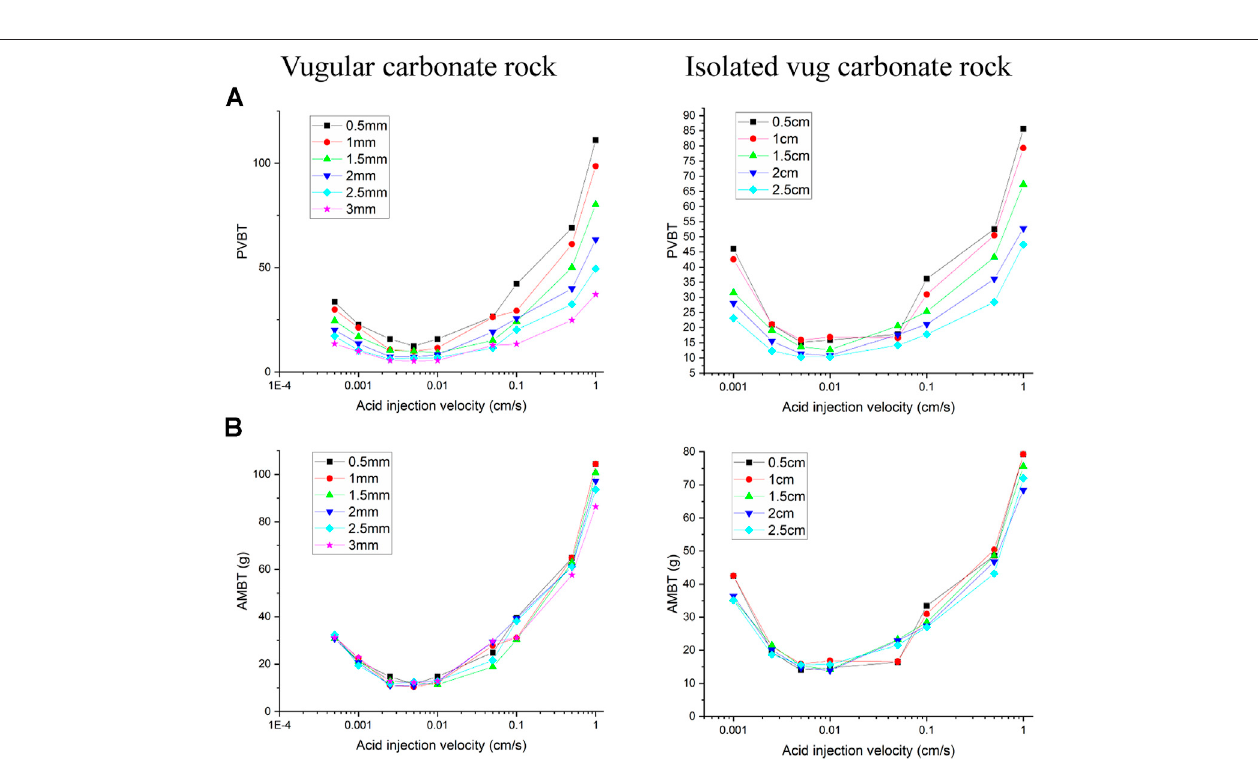
FIGURE 11 | Effect of vug diameter on acidizing curves: (A) pore volume to breakthrough (PVBT) and (B) acid mass to breakthrough (AMBT).